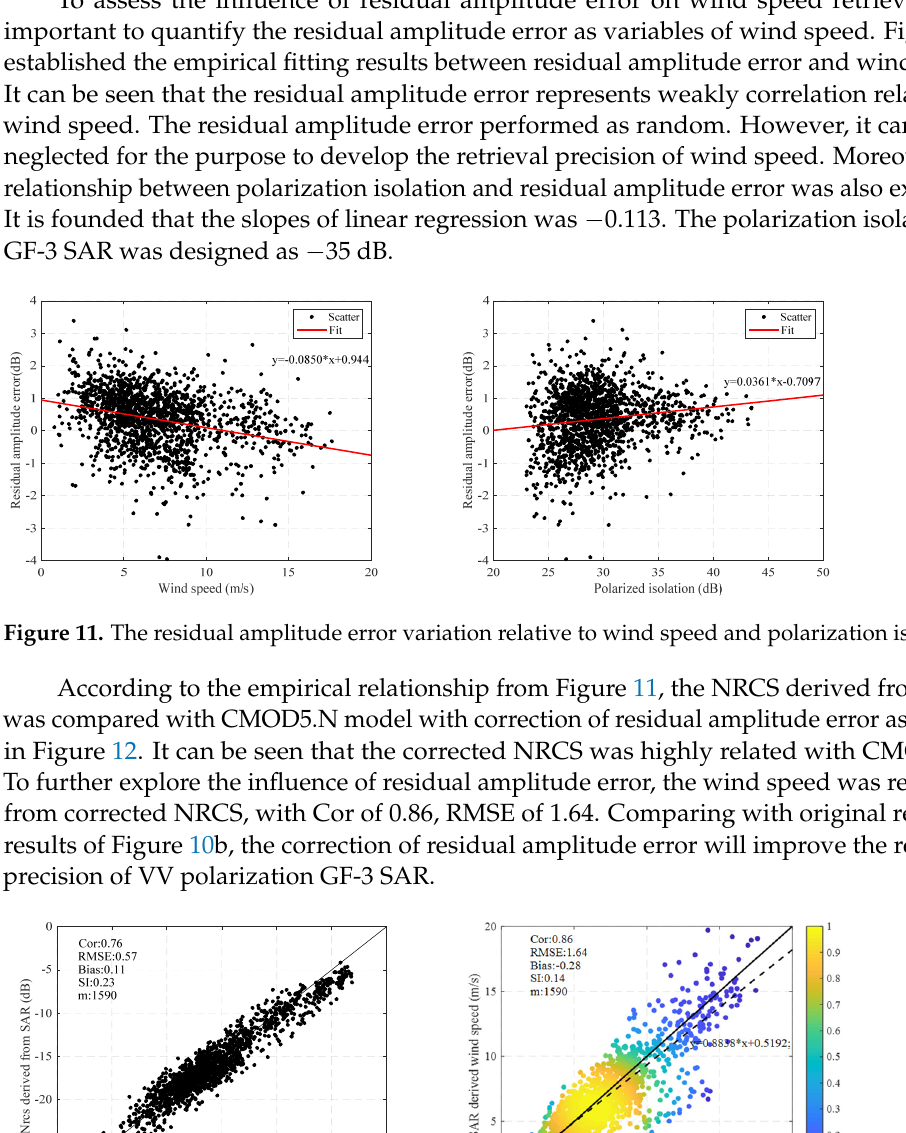
Figure 10. Wind speed retrieval precision for GF-3 SAR HH and VV polarization. The SAR-derived wind speed was compared with on-site wind speed provided by ECMWF: ( a ) CMOD5.N+PR; ( b ) CMOD5.N. The color represents the density of scatter points.